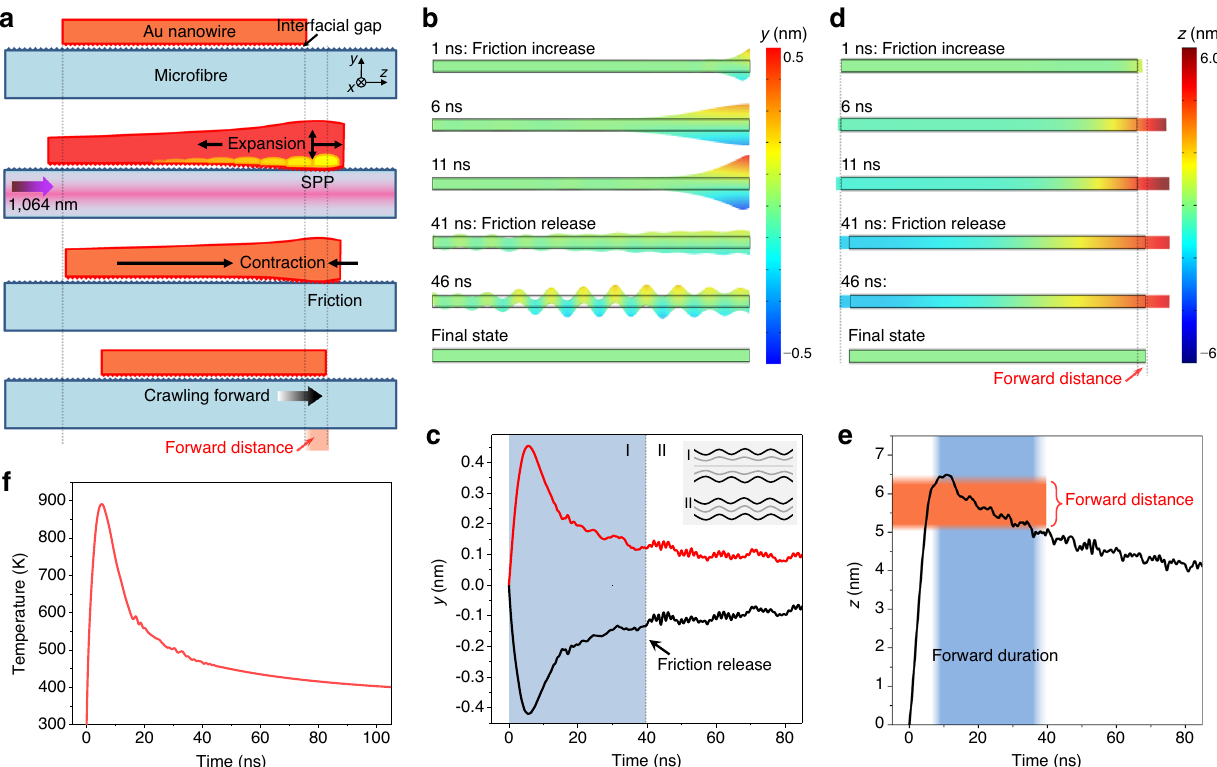
Fig. 3 Peristaltic crawling mechanism of the Au nanowire actuator. a Schematics of the peristaltic crawling of an Au nanowire on a silica micro fi bre. The SPP excited by a 1064 nm pulsed laser causes the nanowire frontend to expand and increases its friction, thus pulling the entire nanowire forward as the nanowire contraction begins. The forward distance is denoted with an orange background. The dimensions of the nanowire and the micro fi bre are the same as those in Fig. 2. Note that there is an interfacial gap at a scale of ~1 nm between the nanowire and micro fi bre. b , d Time-course changes of the nanowire in the y ( b ) and z ( d ) directions upon laser actuation. c Time-dependent vibration behaviors of the upper and lower surfaces of the nanowire frontend, which show a mode of a symmetric plate wave before 40th ns (denoted with a blue background). Inset illustrates the (I) anti-symmetric and (II) symmetric plate wave. e Time-dependent axial expansion behavior of the nanowire frontend. The ranges of forward distance and duration are denoted with orange and blue backgrounds, respectively. f Calculated time-dependent transient temperature change at the nanowire